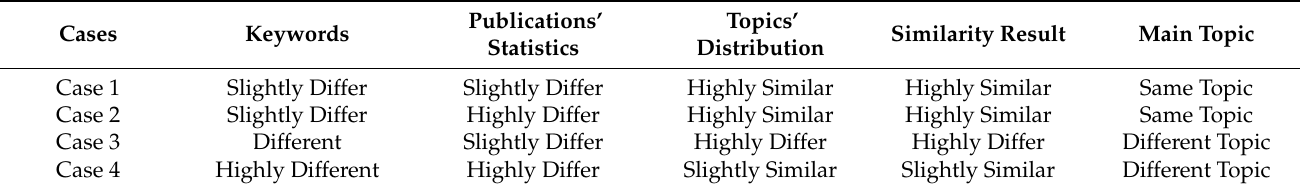
Table 18. Summary of the evaluation